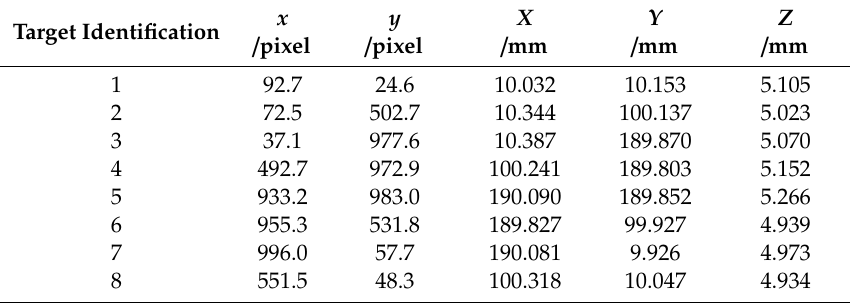
Table 4. Reference targets image and world coordinates—referential B.